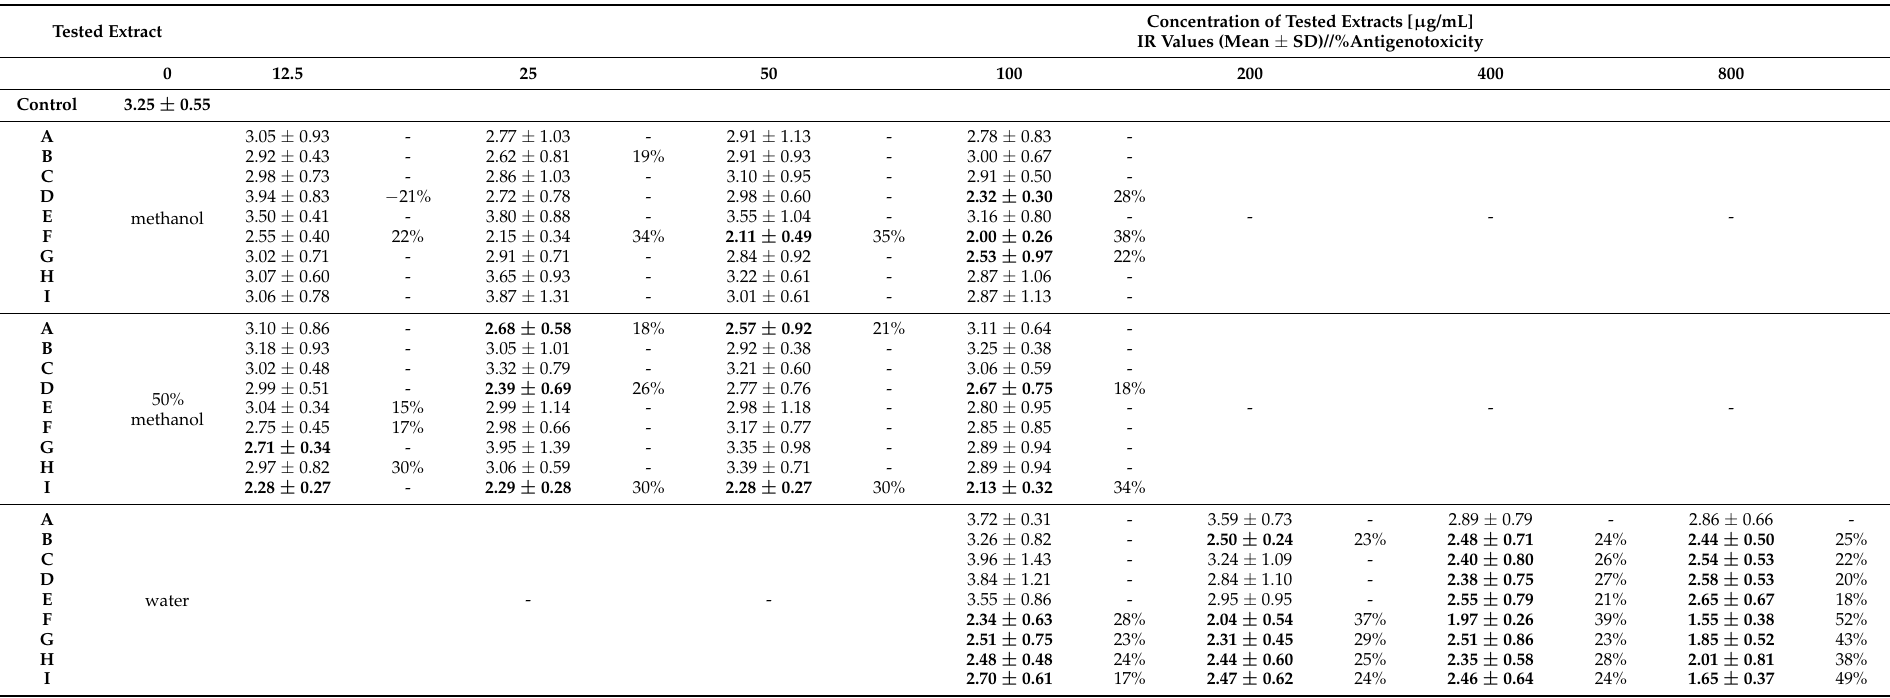
Table 5. Evaluation of antigenotoxic activity based on IR values for the control—genotoxin 2-aminoanthracene (2AA 10 µ g/mL)—and the mixture of 2AA with extracts dissolved in methanol, 50% methanol, or deionized